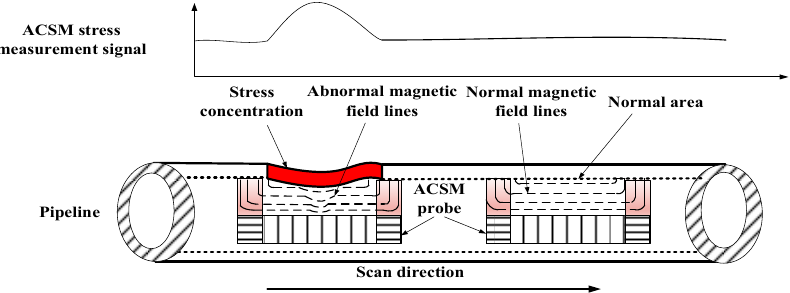
Figure 1. Effects of stress and magnetic field on magnetic domains of ferromagnetic materials.